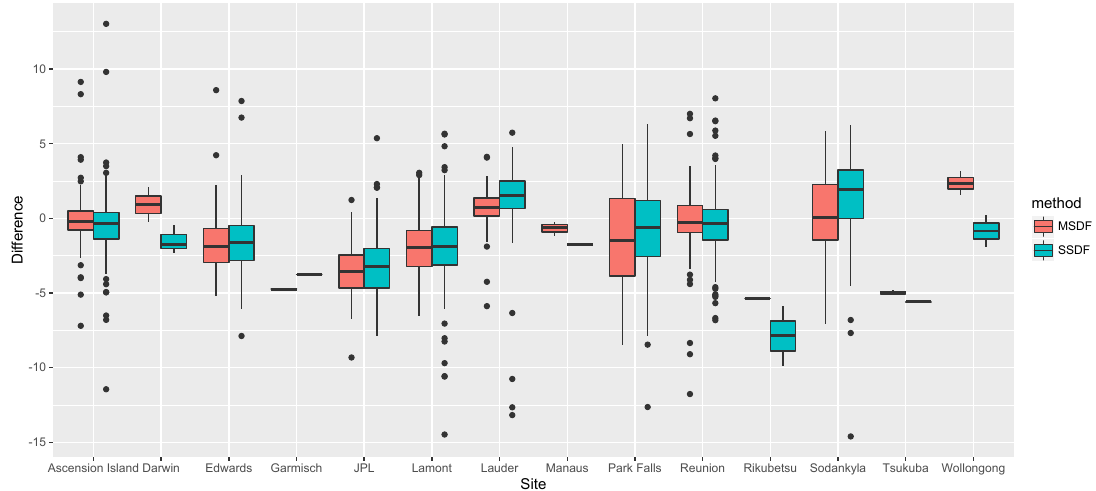
Figure 3. Boxplots of the “predicted minus TCCON” column-averaged CO 2 , where “predicted” is given by SSDF (teal) and MSDF